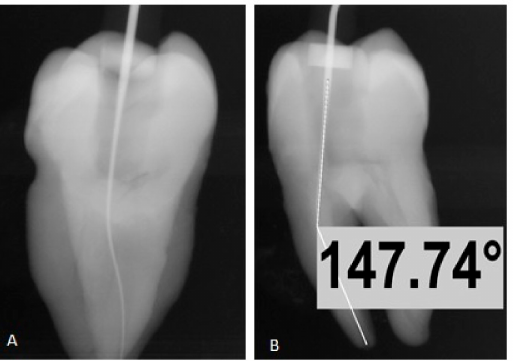
Figure 2. Image ( A ) shows straight instrument in the canal, Image ( B ) shows the maximum curvature of canal (180 ◦ –147.74 ◦ = 32.26 ◦ ) after 90 ◦ rotation of turn table using plywood